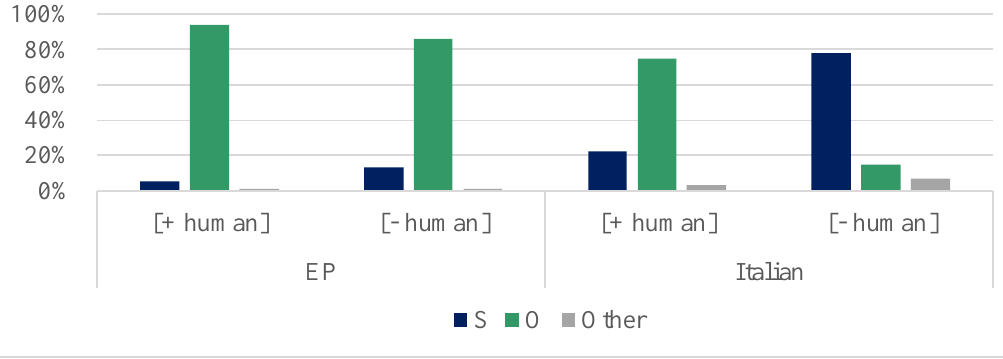
Figure 3. Interpretation of the overt pronominal subject in the speeded task